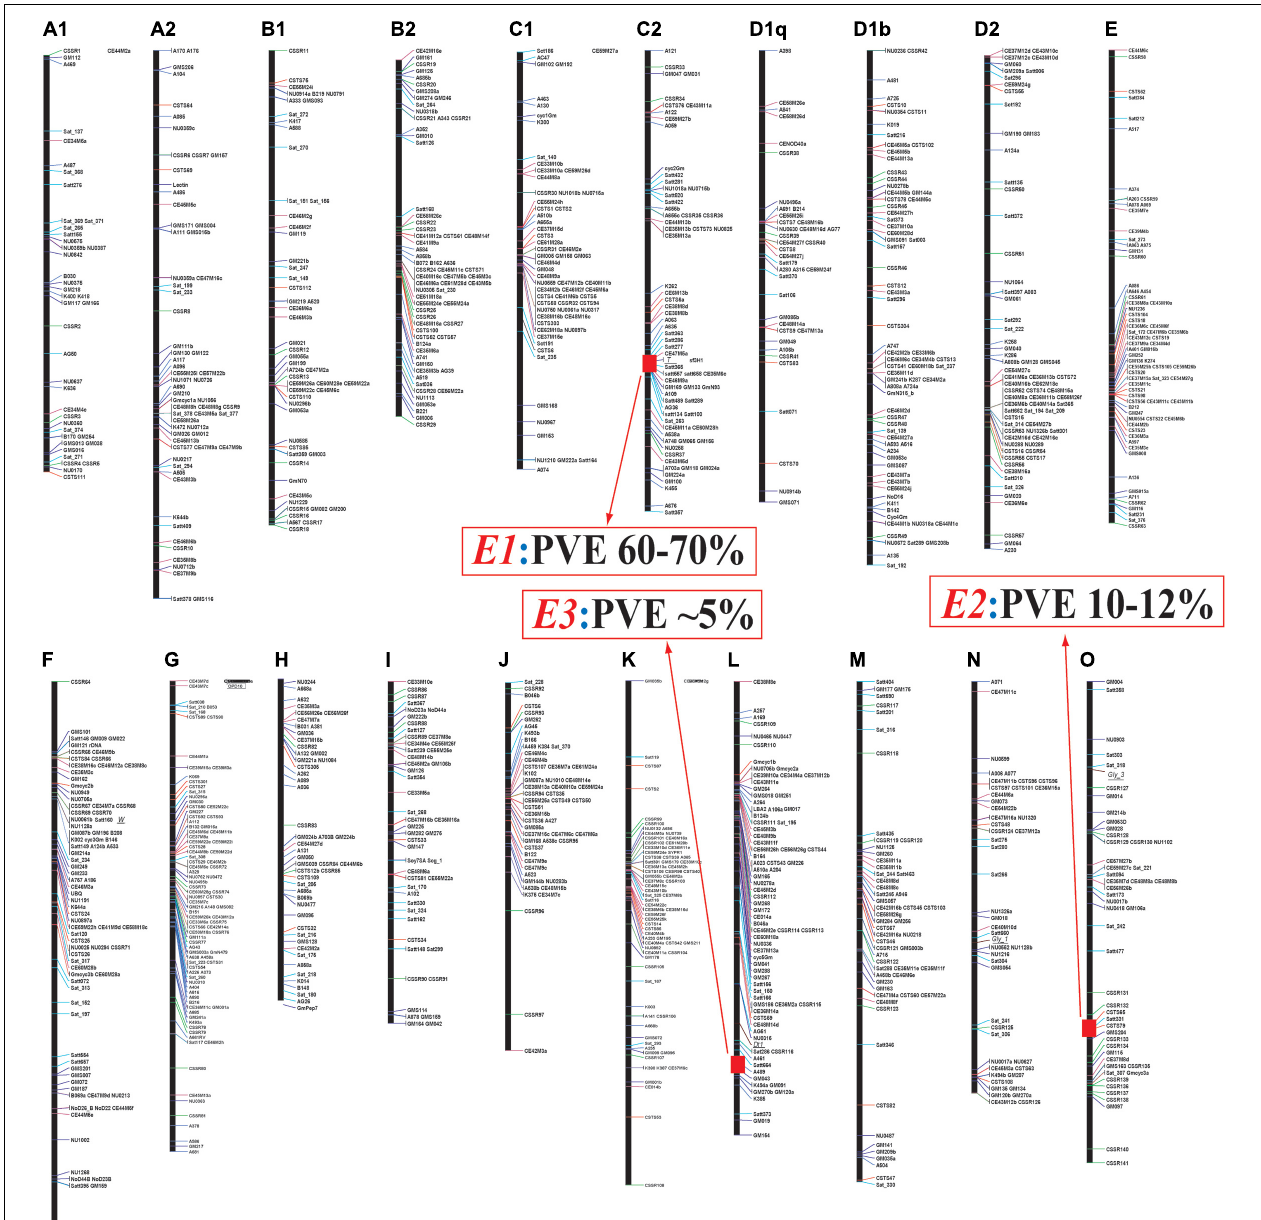
FIGURE 1 | Linkage map construction using an F2 population derived from a cross between Misuzudaizu and Moshidou Gong 503 (adapted from Xia et al., 2007). Identified Quantitative trait loci (QTLs) of E1, E2 and E3 for flowering time were indicated by red segments. PVE, phenotypic variance explained by each QTL. Name of each linkage map is depicted on the